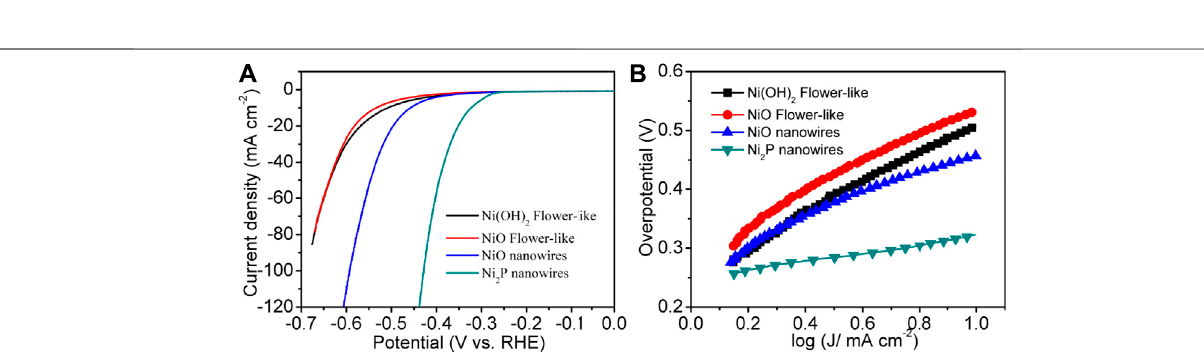
Frontiers in Chemistry |